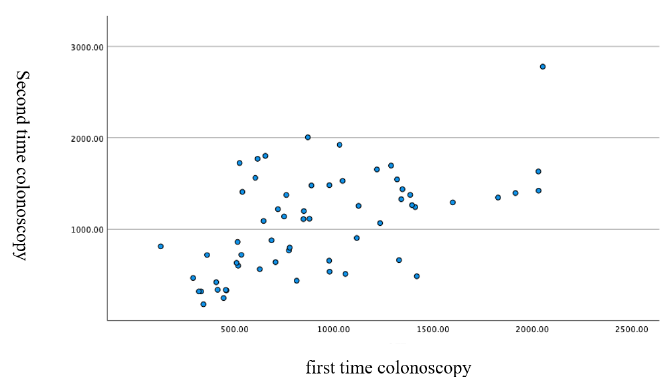
Figure 4. Correlation of the cecal intubation time (i.e., for the total colonoscopy) in the first and the second colonoscopies (scatter plot). Pearson correlation coefficient: 0.55. p < 0.001 two-sided test.